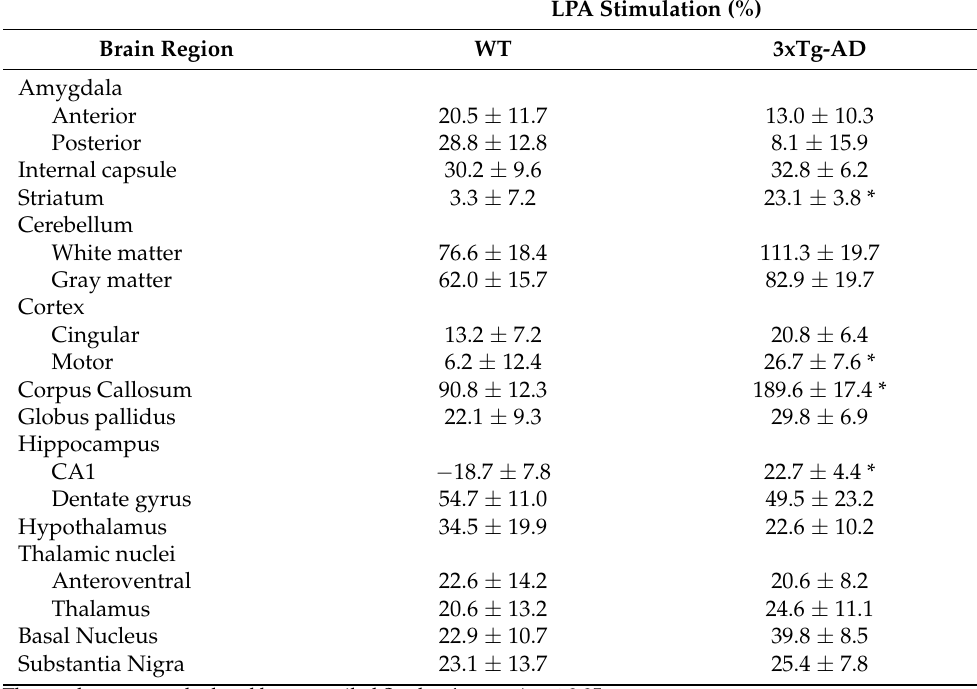
Table 2. [ 35 S]GTP γ S induced by LPA (10 µ M) in different areas of WT and 3xTg-AD mice brain expressed in percentage of stimulation over the basal. n (WT) = 12; n (3xTg-AD) = 16. Data are mean ± SEM